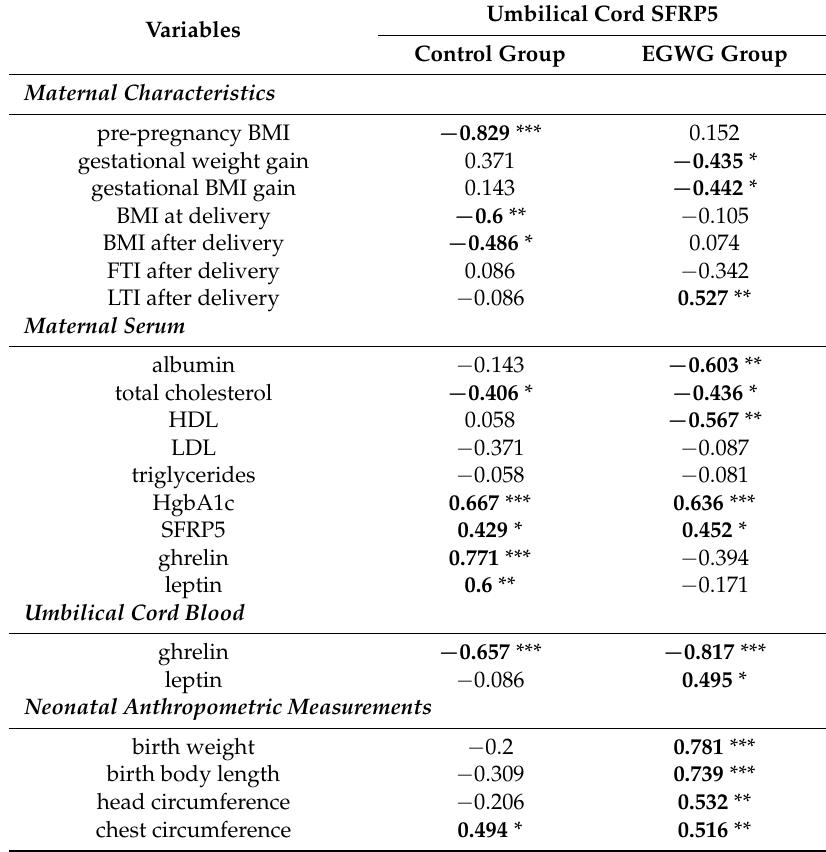
Table 2. Correlation coefficient between the umbilical cord SFRP5 levels and clinical parameters in the control and EGWG